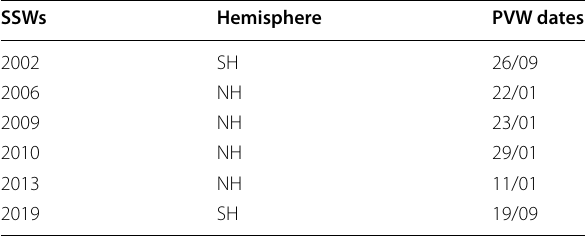
Table 1 List of NH and SH SSWs (year of occurrence) and their respective PVW (dd/mm)